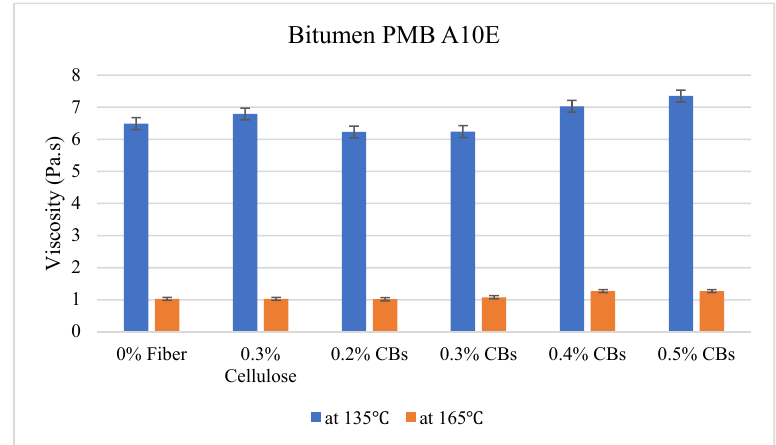
Figure 10. Comparative viscosity of Bitumen PMB A10E modified with different types of fiber.